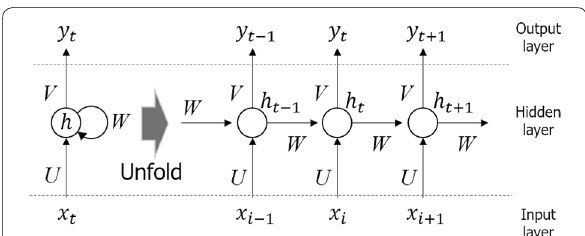
Fig. 3 Internal structure of the RNN system.